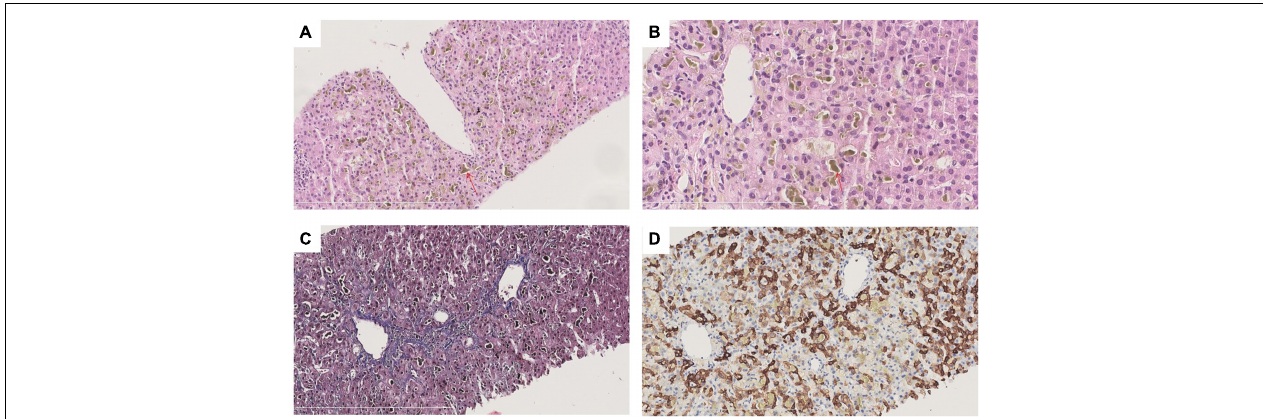
FIGURE 2 | Histological findings of liver biopsy in the patient. (A) HE staining at 200 × magnification; (B) HE staining at 400 × magnification; (C) CK7 staining at 200 × magnification; (D) Masson staining at 200 × magnification. The lobule structure is clear. The main lesions were cholestasis with hepatocytes in central lobules II and III (red arrow), bile embolism with capillary bile ducts and cholestasis with Kupffer cells. No obvious inflammatory necrosis was observed in the lobules. No enlargement in the sink area or obvious inflammatory cell infiltration was noted. No interfacial inflammation was observed. A small bile duct can be identified. The epithelium of the bile duct is arranged in an orderly manner, and there is no bile duct reaction around the sink area. There was no fibrous tissue proliferation in the interstitium of the portal area, and the portal veins were discernible.